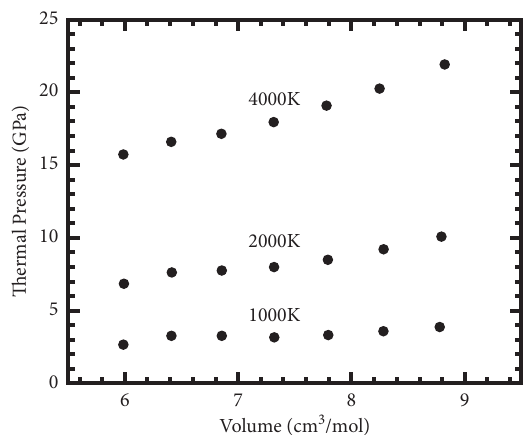
Figure 4: Plot of the thermal pressure calculated using first- principles molecular dynamics. Solid circles represent the calcu- lated thermal pressures at 1000, 2000, and 4000K.